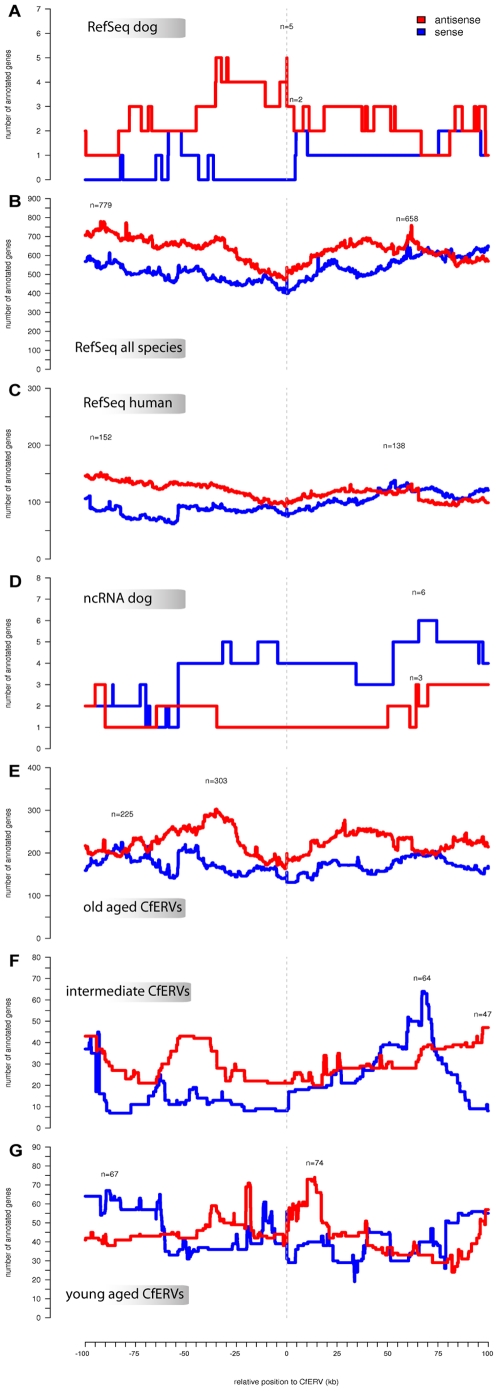
Gene neighboring CfERVs plot.On the x-axis, the distance in bp 3′ and 5′ of the CfERVs in a 200 kb surrounding window [-100 kb, 100 kb] are shown. Position zero refers to the exact location of the CfERV. The presence of genes within each region is shown for the sense (in blue) and antisense (in red) strands. The region with the highest number of genes is marked with the number of genes indicated. A) UCSC RefSeq dog annotated genes; B) including all other UCSC listed species (except dog) annotated genes (xref); C) protein coding genes annotated with only UCSC projections of human genes in the dog genome; D) UCSC xref track annotations counting only ncRNA human genes. E) anciently integrated (>10% LTR divergence); F) intermediately integrated (> = 5% and < = 10%); G) recently integrated (<5%). A visual explanation of the methodology used to calculate the histogram values is sketched in Fig. 3B.